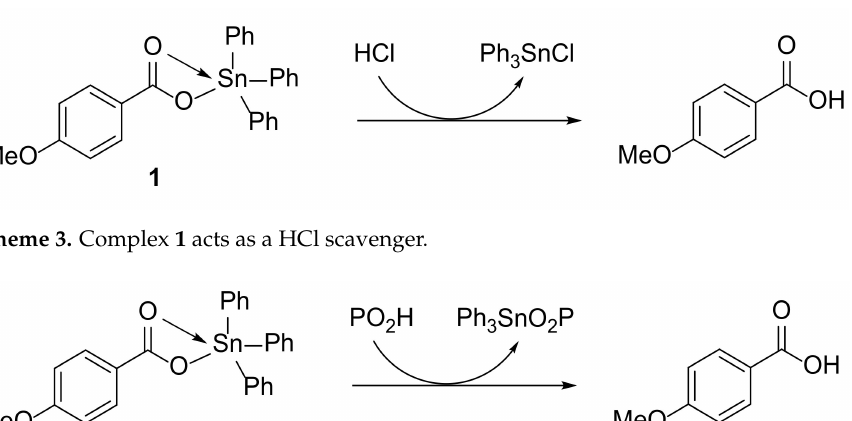
Figure 11. Coordination of 1 with PVC.